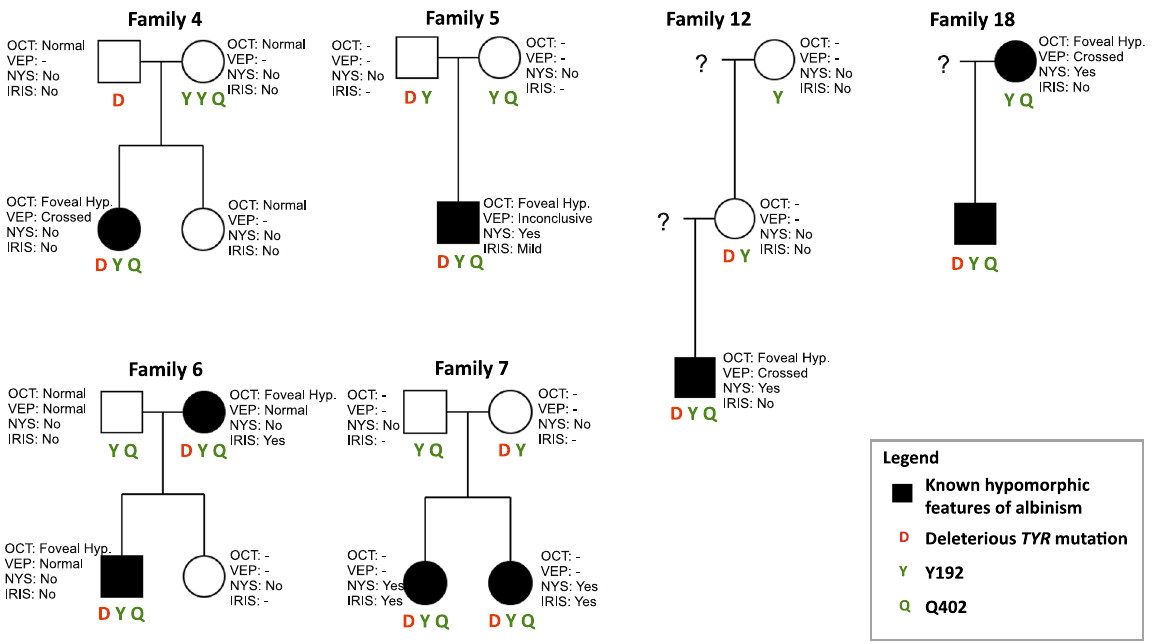
Figure 2. Pedigree diagrams for six families with a single TYR pathogenic mutation and common polymorphism phenotyping. TYR variants are listed beneath each family. Sanger sequencing was performed on family members as opposed to the full exonic region sequenced in probands. Family number corresponds with proband